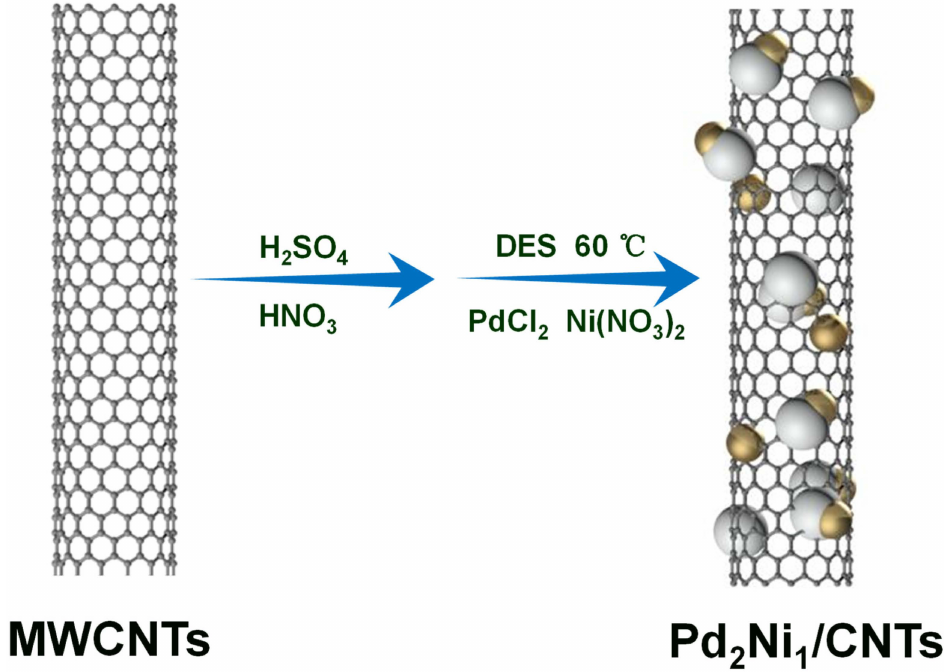
Scheme 1. Schematic illustration showing the preparation of Pd 2 Ni 1